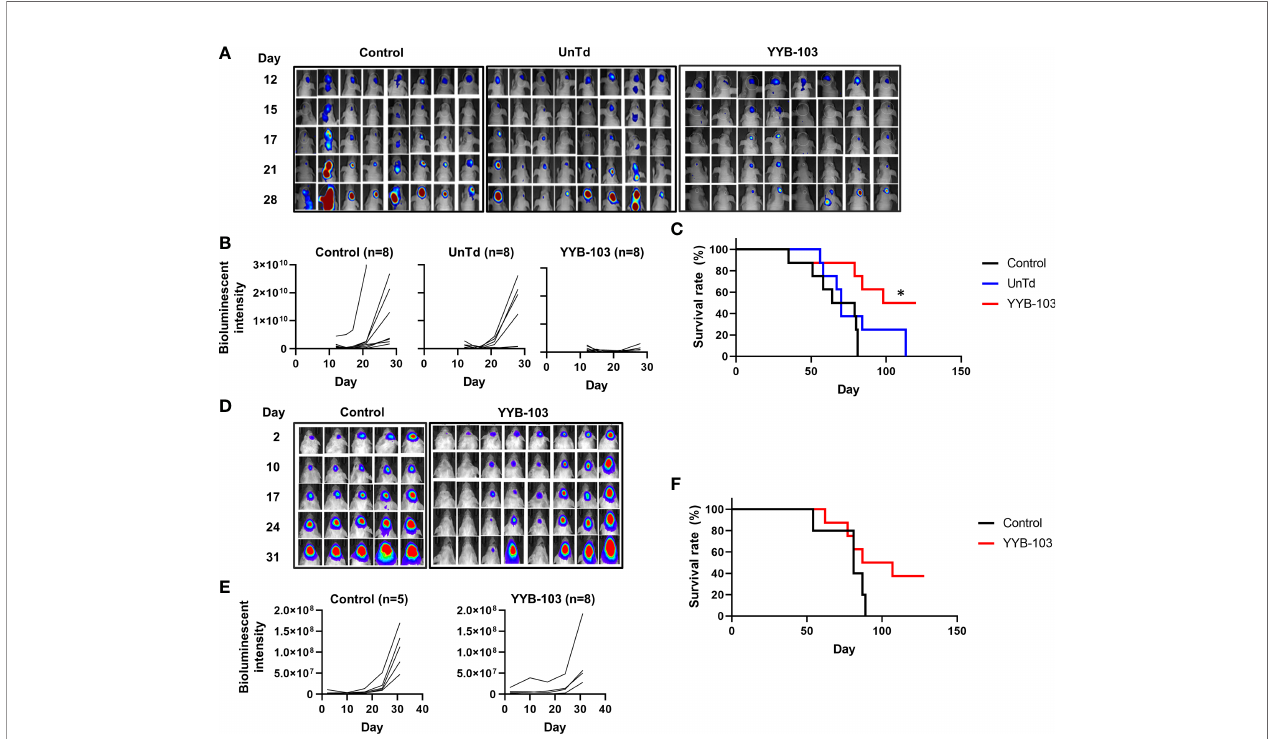
FIGURE 3 | In vivo antitumor activity of YYB-103 CAR T cells. ( Top row ) Nude mice were orthotopically injected with U87 human glioma cells expressing luciferase (U87-luc) and further received PBS, UnTd T cells, or YYB-103 CAR T cells via an i.c.v. route. Survival and tumor growth were routinely monitored. (A) Optical imaging of U87-luc cells in nude mice were obtained using VISQUE in vivo Elite on the indicated days. (B) Bioluminescence intensities were calculated from the images. (C) Survival rate of each group of mice. Log-rank Mantel – Cox test was performed, * p < 0.05. ( Bottom row ) Control (PBS) and YYB-103 CAR T cells were i.v. injected into NSG mice that were orthotopically injected with U87-luc. Survival and tumor growth were routinely monitored. (D) Optical imaging of U87-luc cells in NSG mice on the indicated days. (E) Bioluminescence intensities were calculated from the images. (F) Survival rate of each group of mice. CAR, chimeric antigen receptor; PBS, phosphate-buffered saline; UnTd, untransduced; i.c.v., intracerebroventricular; i.v.,